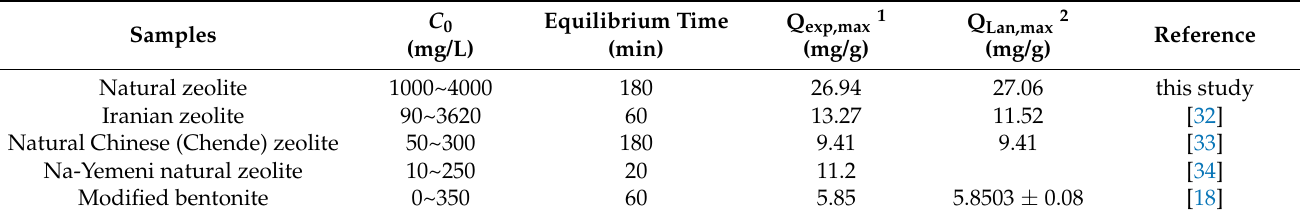
Table 3. Adsorption characteristics to ammonium by the selected Chinese natural zeolite and other reported